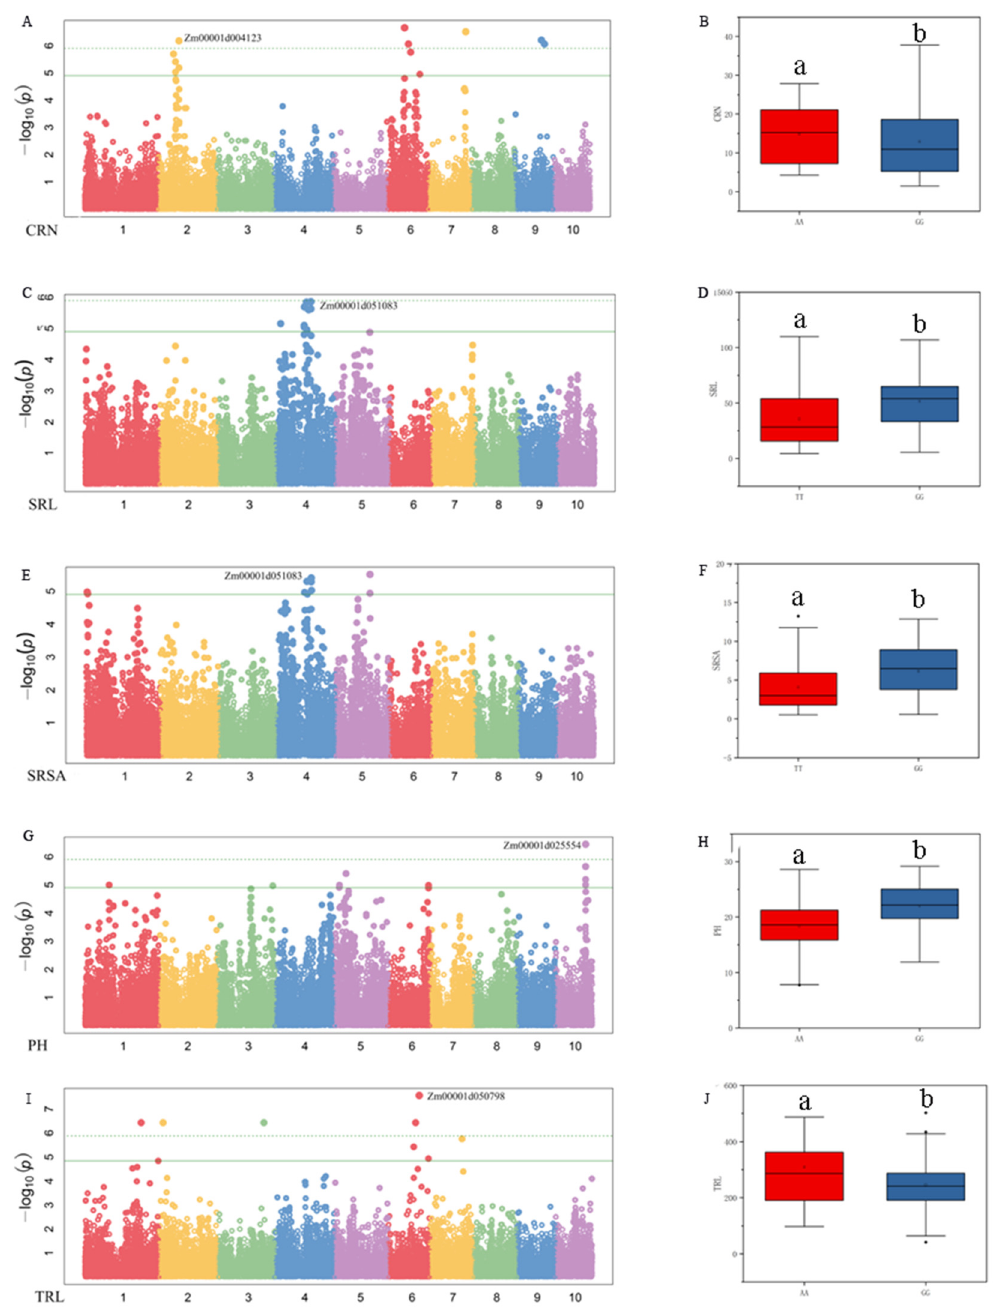
Figure 5. Manhattan plot of nitrogen efficiency-related traits and allelic effects of significant SNPs corresponding to genes. ( A , B ) Manhattan plot of CRN under LN and the Zm00001d004123 corre- sponding to the allelic effect of significant SNP; ( C , D ) Manhattan plot of SRL under CK and the Zm00001d051083 corresponding to the allelic effect of significant SNP; ( E , F ) Manhattan plot of SRSA under CK and the Zm00001d051083 corresponding to the allelic effect of significant SNP; ( G , H ) Man- hattan plot of PH under LN and the Zm00001d025554 corresponding to the allelic effect of significant SNP; ( I , J ) Manhattan plot of TRL under CK and the Zm00001d050798 corresponding to the allelic effect of significant SNP. In the figure, the upper edge of the boxplot represents the maximum value, the lower edge represents the minimum value, the open circles represent the mean, the filled circles represent the outliers, and contains a line representing the median. a and b indicate significance between CK and LN ( p < 0.05).